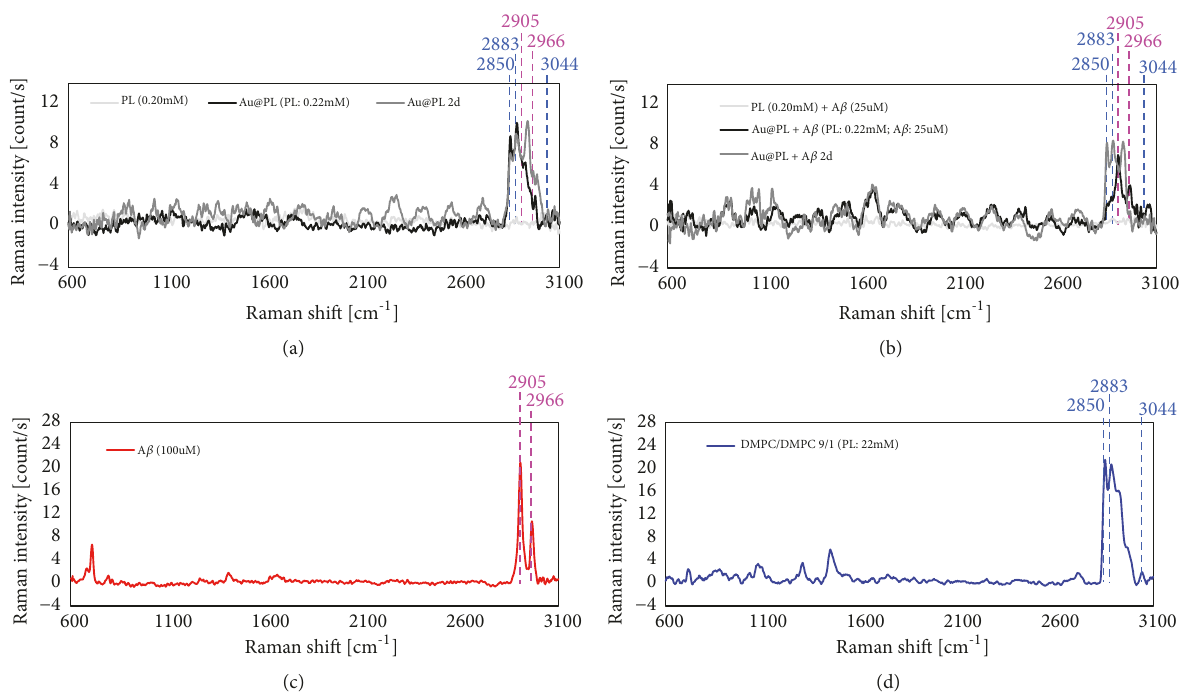
Figure 4: Raman spectra of (a) Au@PL and (b) Au@PL with A 𝛽 25 𝜇 M before (gray line) /after (black line) 2 days incubation at 37 ∘ C. The corresponding Raman spectra of (c) A 𝛽 and (d) PL vesicles are shown for